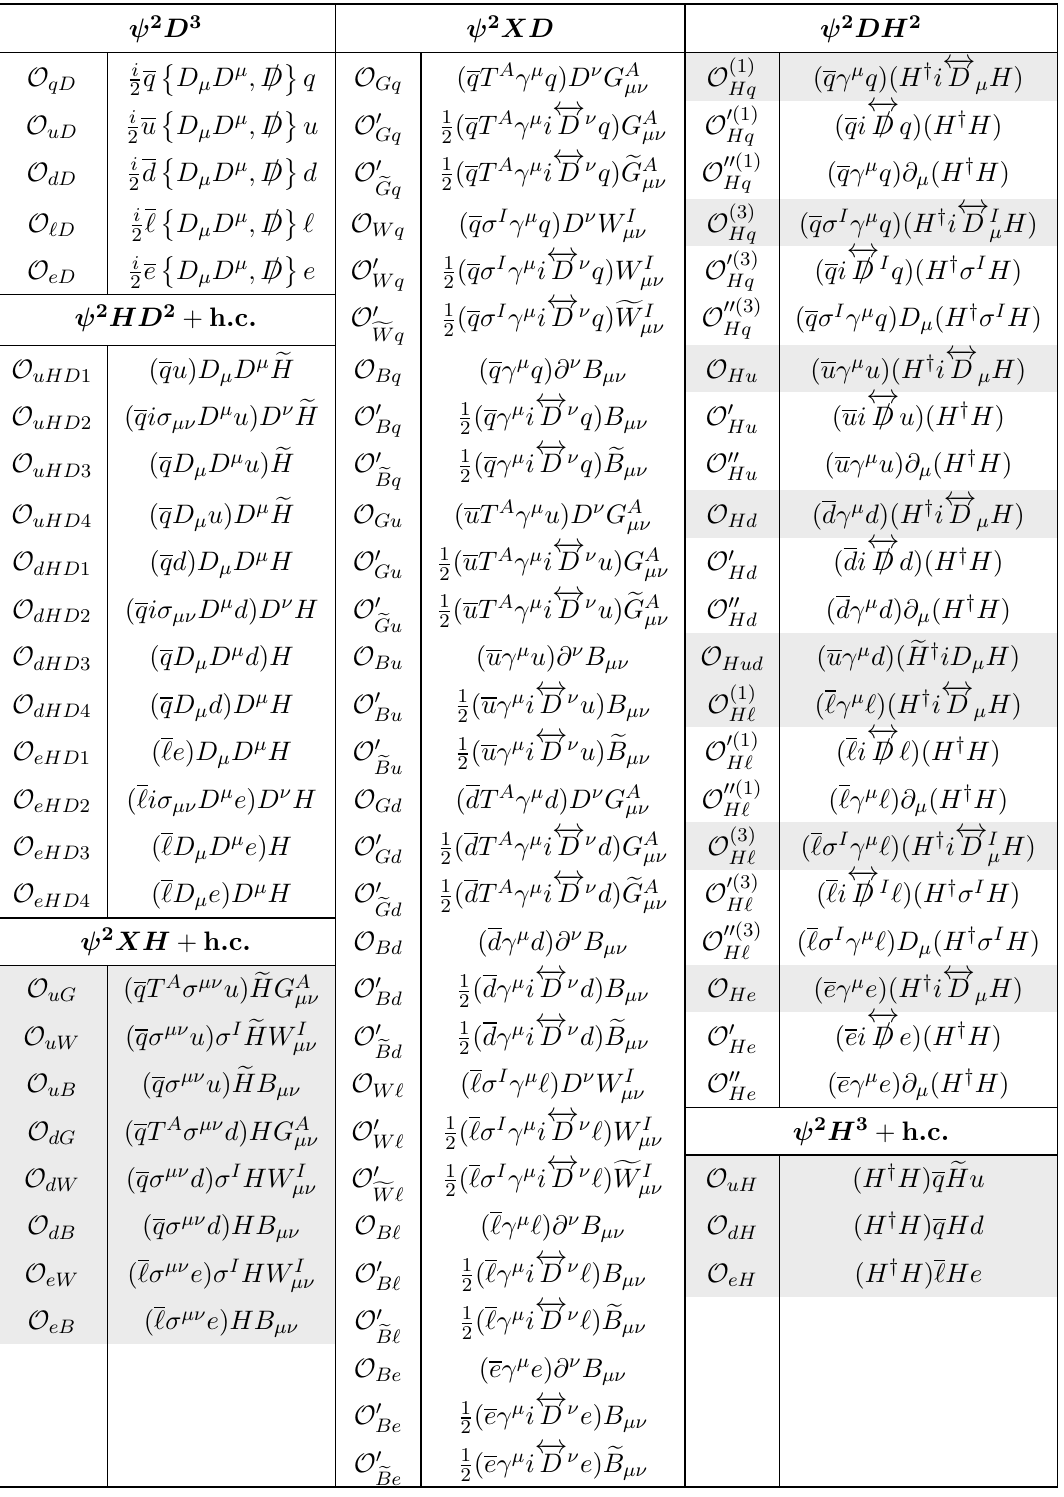
Table 2 . Two-fermion operators in the Green’s basis. Shaded ones are also included in Warsaw basis. Fermion family indices are